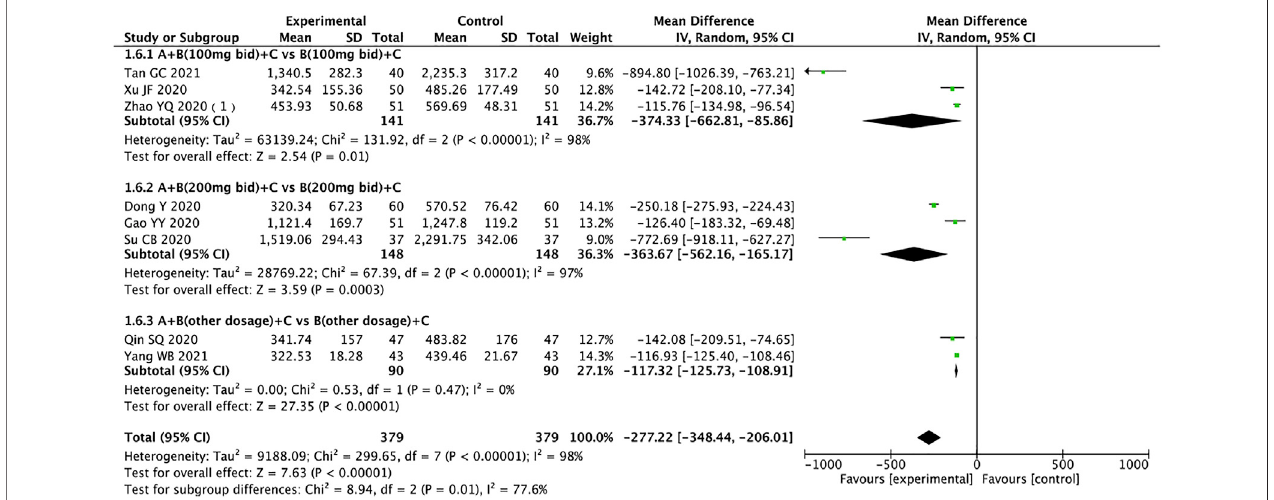
FIGURE 8 | Forest plot of NT-proBNP.